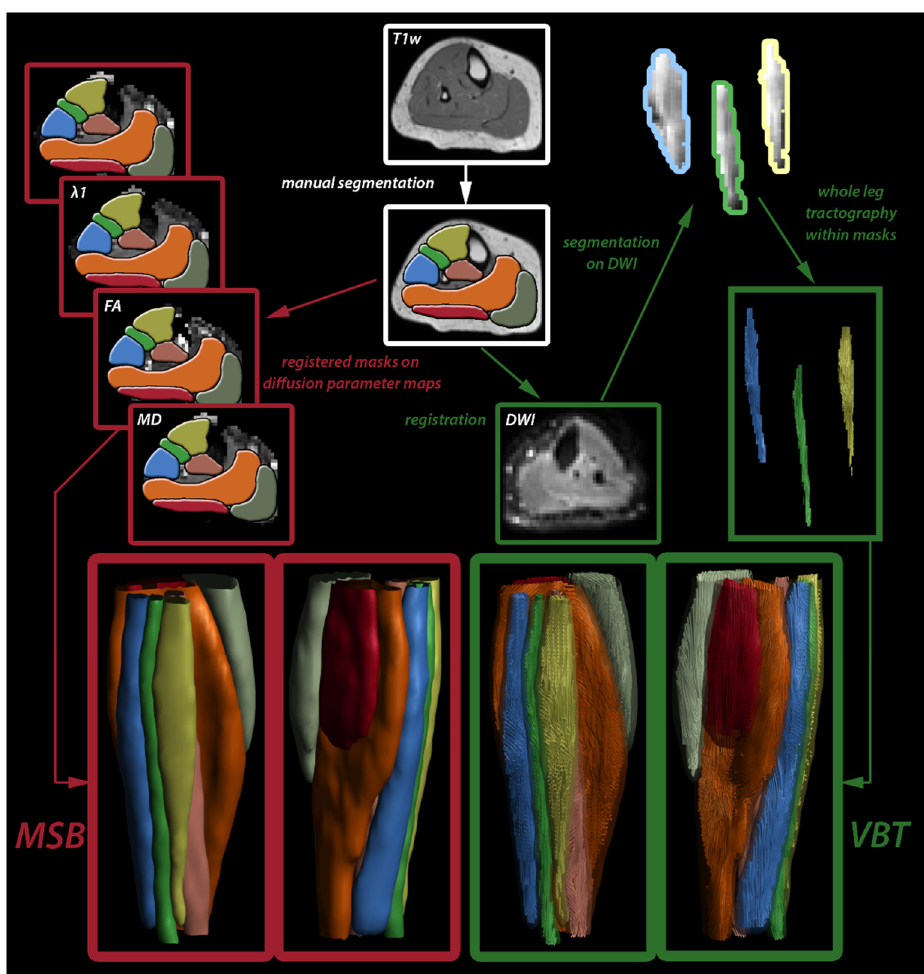
Figure 1. Overview of segmentation processes (MSB = manual segmentation, VBT = volume-based tractography).